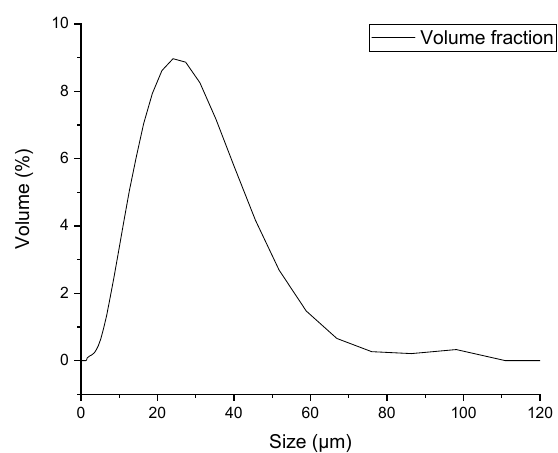
Figure 1. Particle size distribution for sieved powder. Coatings 2020 , 10 , x FOR PEER REVIEW